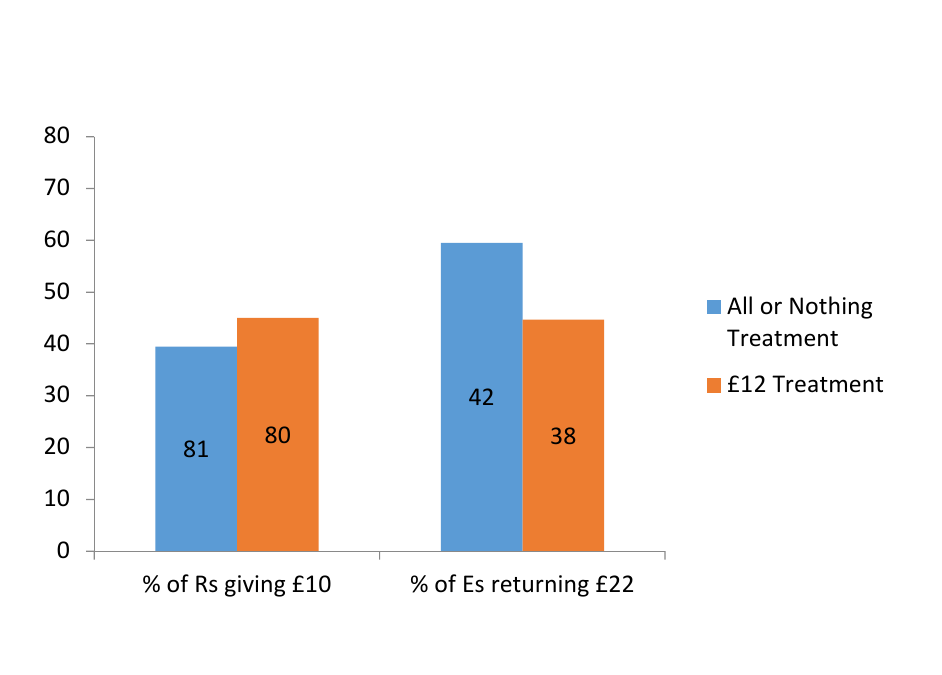
Figure 2: All or nothing treatment effect. (Ns in the